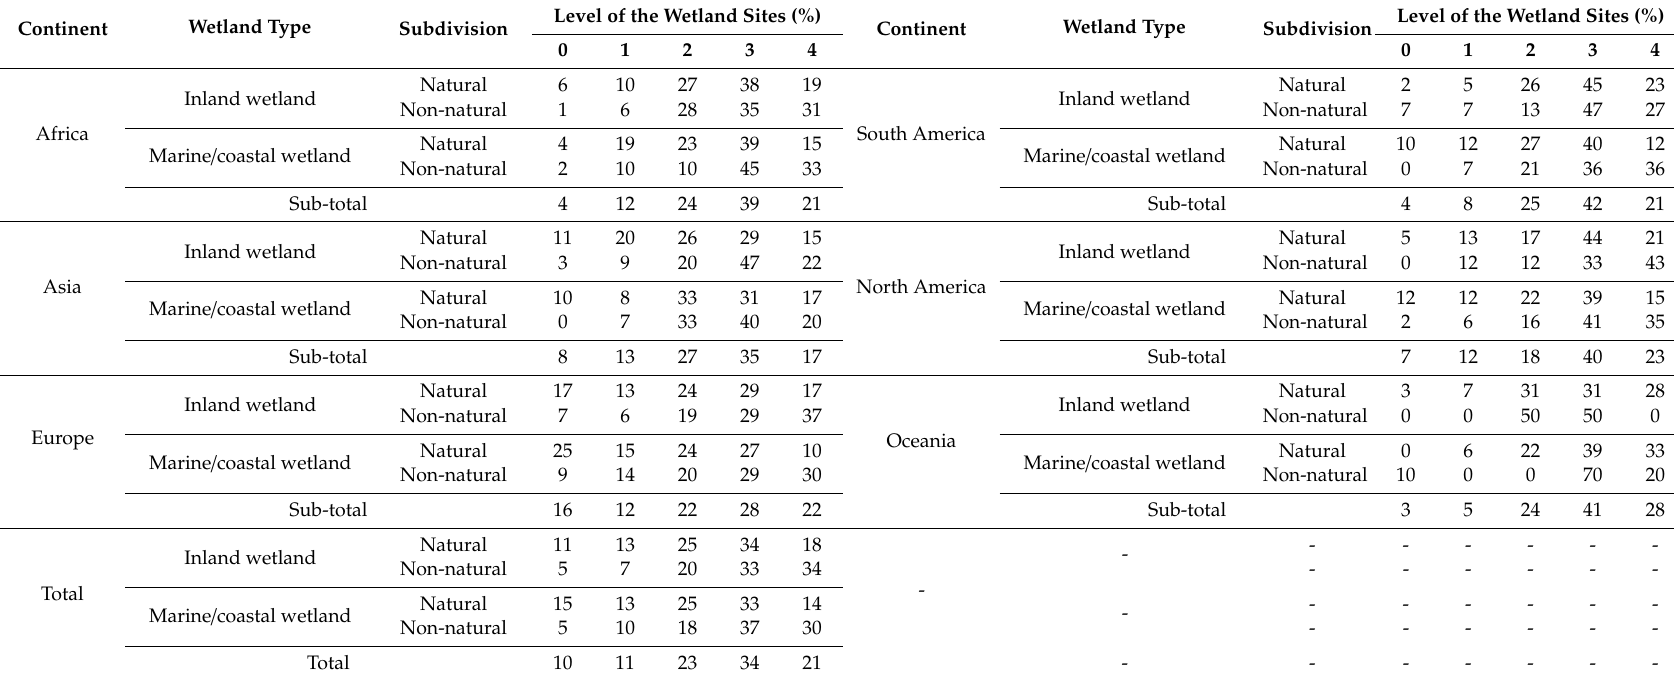
Table 2. The levels of the wetland sites in each continent